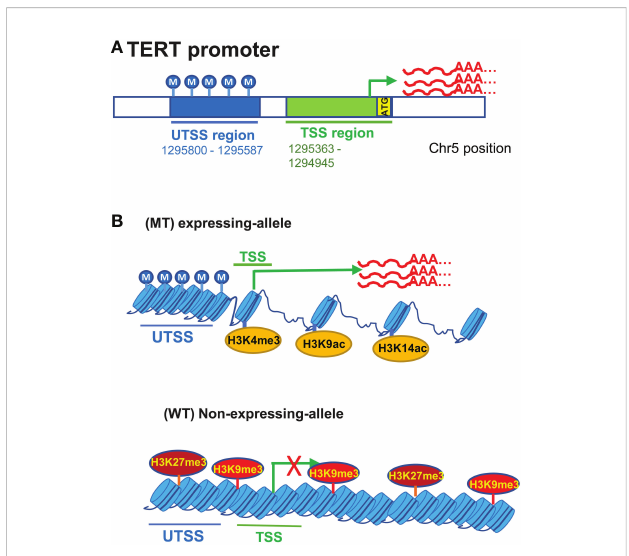
FIGURE 3 The featured TERT promoter methylation pro fi le and its interplays with TERT promoter mutations for TERT expression in urothelial carcinomas (UCs). (A) hypermethylated upstream of the transcription start site (UTSS) region while hypomethylated (transcription start site) TSS or proximal promoter region in UC cells. (B) TERT promoter mutations and relation to the allele-speci fi c TERT transcription and promoter methylation. The allele-speci fi c activation of the TERT transcription leads to biallelic or monoallelic expression (BAE or MAE) of TERT. In UC cells carrying heterogenous TERT promoter mutations, MAE is in general predominant. The mutated (MT) allele is active, coupled with the featured promoter methylation pro fi le and open chromatins marked by H3K4 trimethylation (H3K4me3) and H3K9/14 acetylation (Top), while the wild type (WT) allele lacks the UTSS hypermethylation and is associated with the repressive histone markers including H3K27me3 and